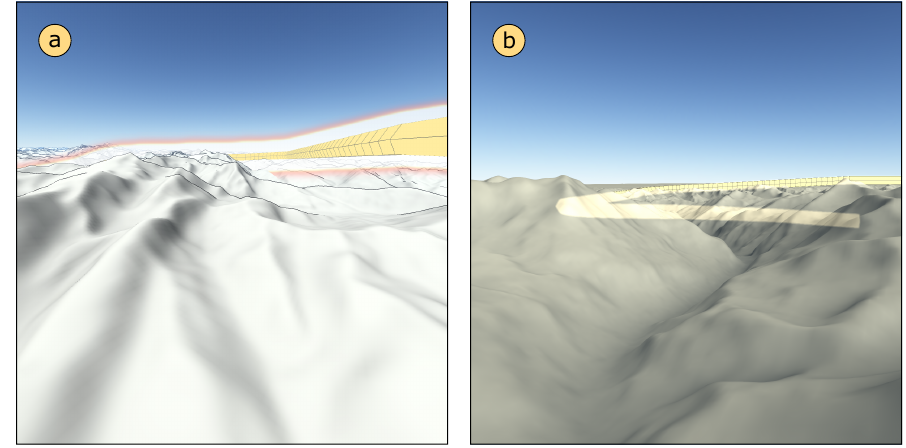
Figure 11. Improving communication of the position and path of the trajectory. ( a ) depicts a halo around the trajectory to increase its prominence; in ( b ), the geometry of the trajectory shines through the terrain if it is